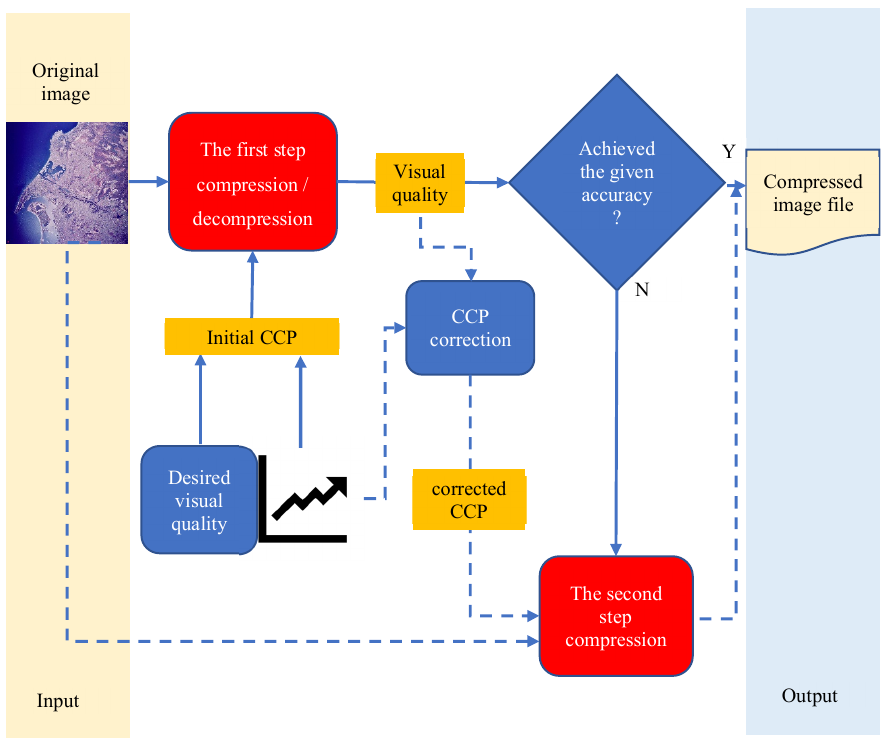
Figure 3. The block diagram of the two-step compression F IGURE 2: The block diagram of the two-step compression method 31